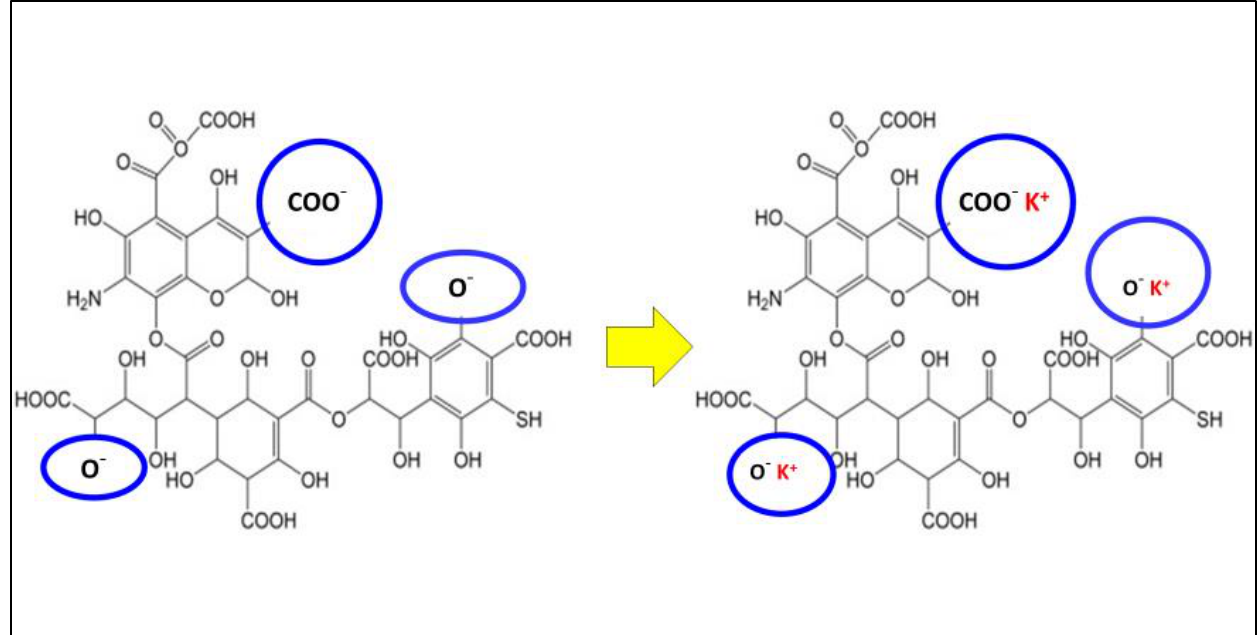
Figure 4. Proposed mechanism of potassium retention at the negatively charged exchange sites of organic amendments (adapted from Troeh and Thompson [64]).